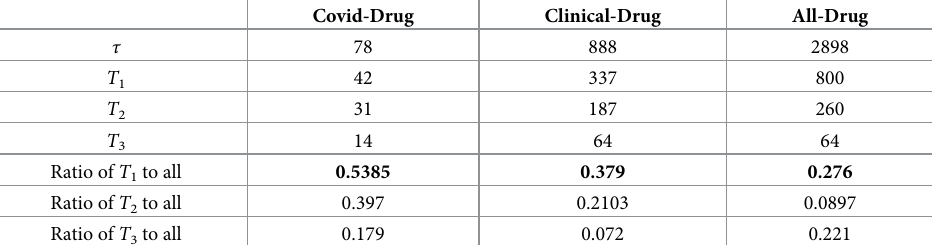
Table 4. The number of protein targets in each candidate set for All-drug, Clinical-Drug, and Covid-Drug groups reported in the four first rows. The ratio of the number of targets presented in the second, third, and fourth rows to the total number of proteins targeted by these three groups of drugs reported in the fifth, sixth, and seventh rows